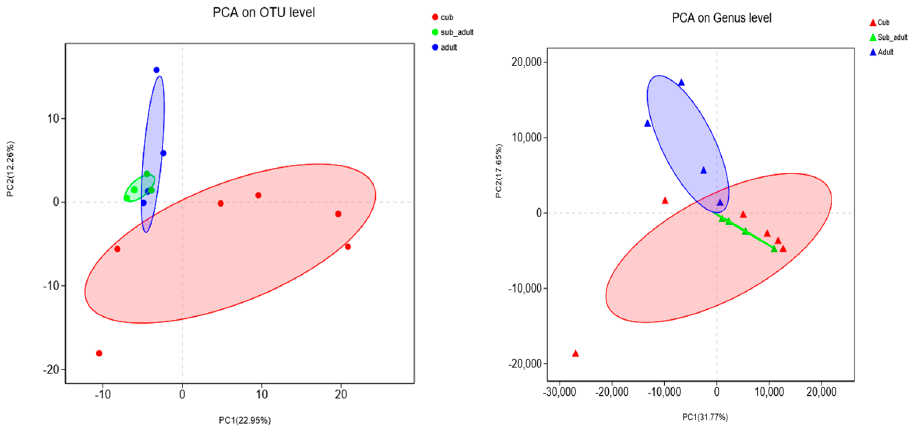
Figure 5. PCA Analysis of Intestinal Bacterial ( left ) and Fungal ( right ) Communities in Giant Pandas at Different Developmental Stages.